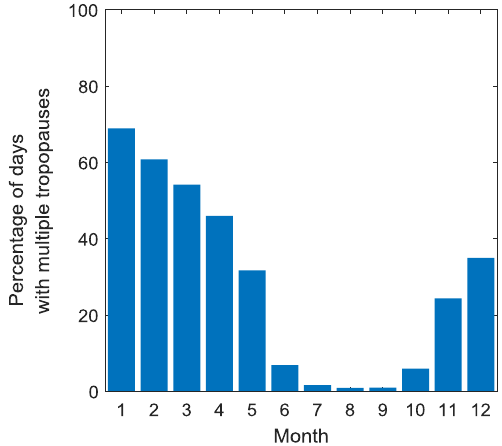
Figure 12. Monthly distribution of occurrences (in %) of double tropopauses above TMF. The number of days with tropopause folds is normalized to the total number of measurements per month com- piled in Table